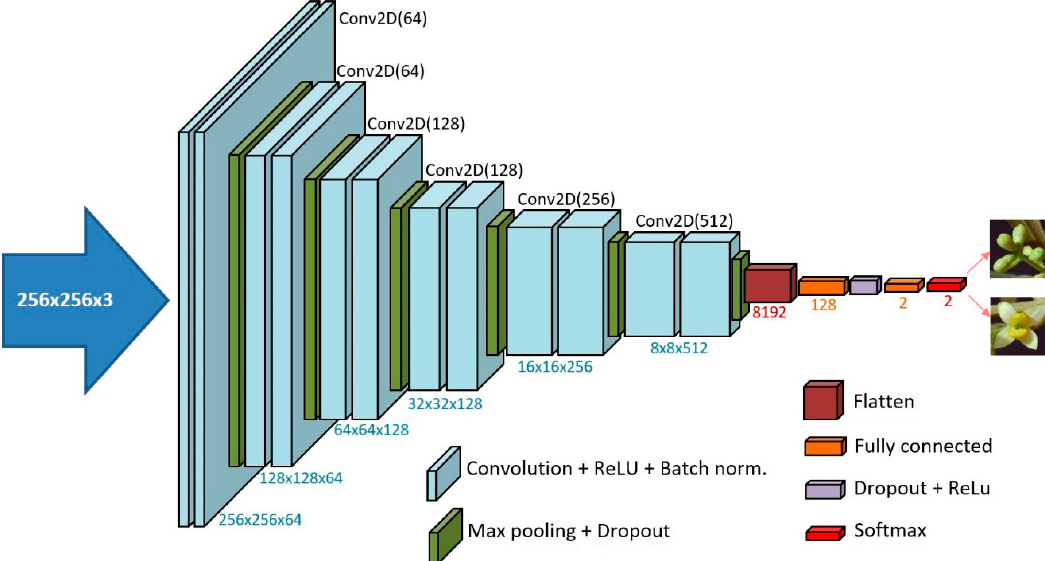
Figure 4. The structure of the custom convolutional neural network (CNN).